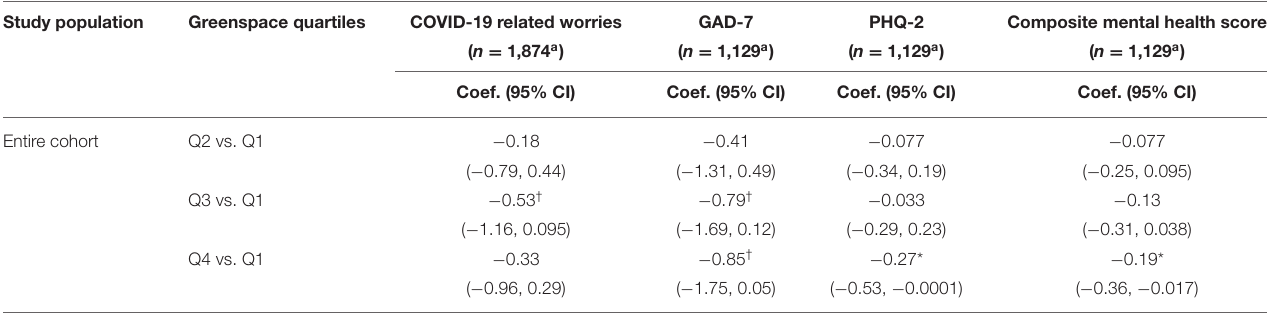
TABLE 2 | Greenspace and COVID-19-related worries, anxiety, depression, and composite mental health scores among all surveyed participants, multivariate regression analysis with multilevel models. Study